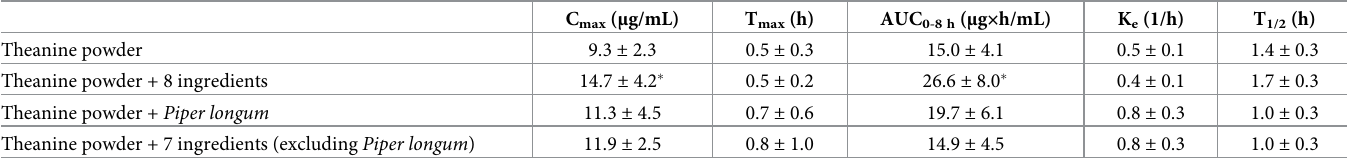
Table 1. Pharmacokinetic parameters of theanine after oral administration of each formulation.